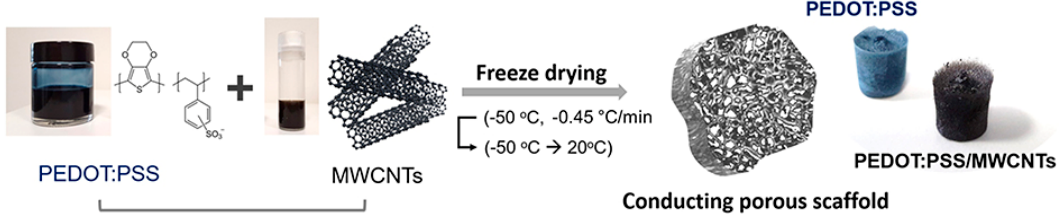
Figure 19. The components and process used for the fabrication of 3D conducting sca ff olds. The photos show free-standing conducting sca ff olds based on PEDOT:PSS and PEDOT:PSS / multi-walled carbon nanotubes (MWCNTs) [196]. Reproduced with permission from Jayaram et al., Frontiers in Chemistry ; published by Frontiers Media S.A., 2019.